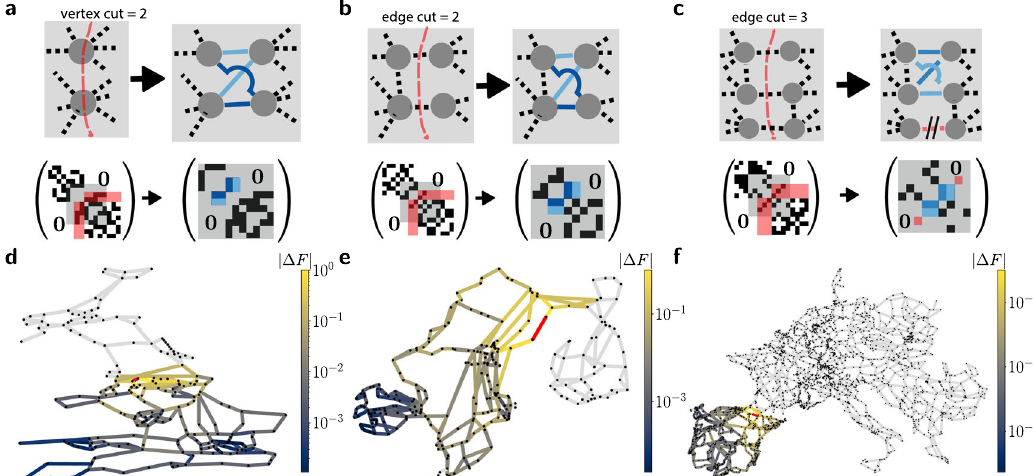
Fig. 3 Different ways of constructing isolators in real-world power grids. a – c Alternative methods of creating an isolator in a given network. We show the network structure before (top left) and after (top right) the addition of a network isolator, as well as corresponding adjacency matrices (bottom) with the different shades of blue representing the weight A ij of the respective edge. A lower prior connectivity simpli fi es the creation of isolators as measured by the vertex cut ( a ) or edge cut ( b , c ) which is visible in the adjacency matrix (entries colored red). The creation of network isolators results in characteristic patterns in the adjacency matrix in terms of the capacities of the isolator edges (shades of blue). d – f Realisation of network isolators in real-world power grids. We construct network isolators in the British power grid ( d ), the Scandinavian power grid ( e ) and the Central European power grid ( f ) using the recipes illustrated in ( a – c ). For each power grid, we colour code the fl ow changes after the failure of a single link carrying a unit fl ow (red). In each case, the network isolator inhibits fl ow changes, i.e. Δ F = 0, (light grey) in the part of the network that is shielded by the